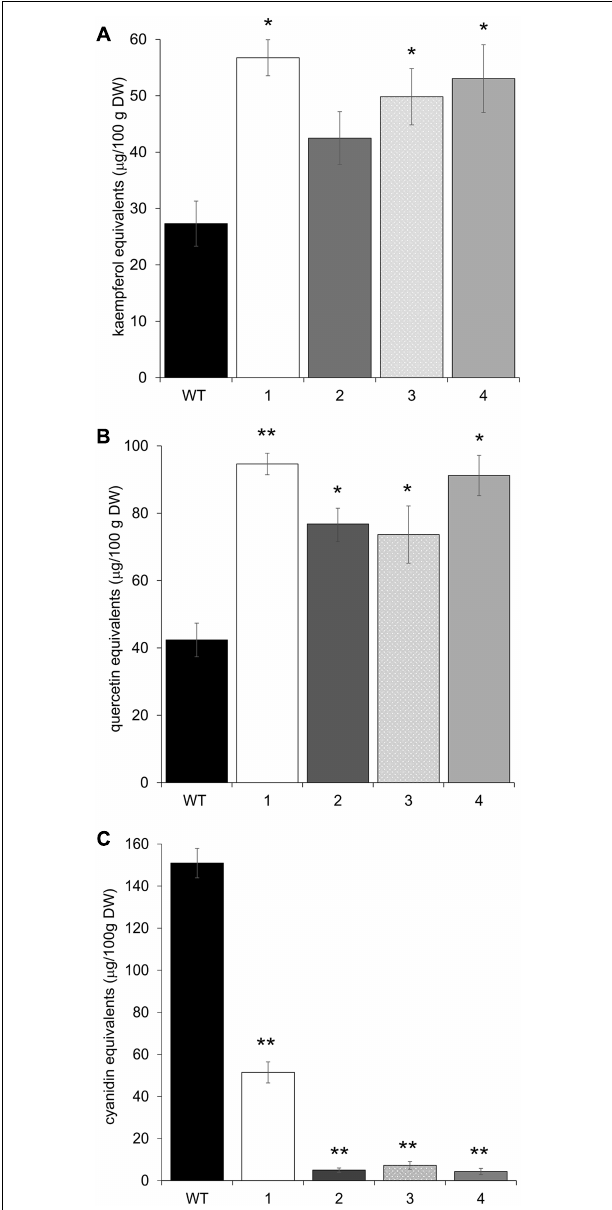
FIGURE 5 | HPLC flavonol and anthocyanin quantification in Arabidopsis plants overexpressing CcMYB12 protein. Leaves were analyzed from wild type (WT) plants and from four different Arabidopsis pools (1–4), each constituted by four plants of the same transgenic T3 line. (A) total kaempferols, (B) total quercetins, (C) total anthocyanins. Error bars indicate the SD of the average of quercetin, kaempferol or cyanidin equivalents determined as triplicates in three independent biological replicates. Asterisks ∗ and ∗∗ indicate statistically significant differences ( P < 0.05 and P < 0.01 respectively) between the means for WT and tested transgenic samples according to Student’s t -test. DW, dry